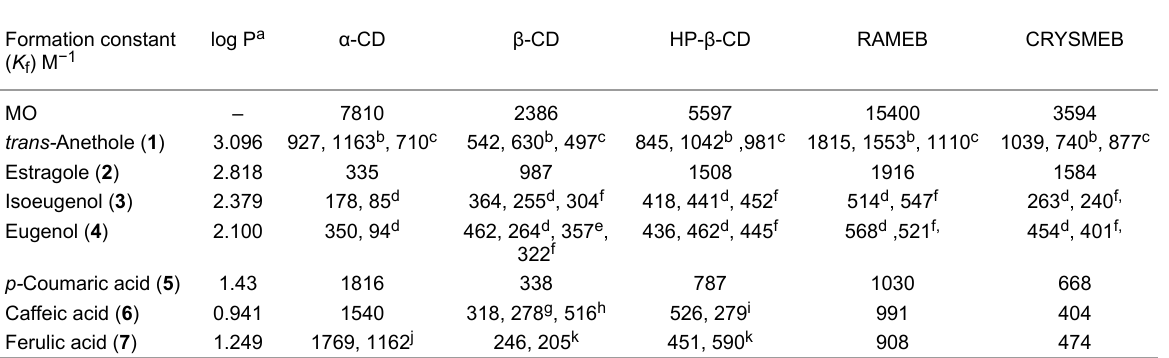
Table 1: Formation constants ( K f ) of CD/MO and CD/PP inclusion complexes obtained by UV–visible spectroscopy using a spectral displacement method in comparison with values from the literature. Standard deviation values are <10%.